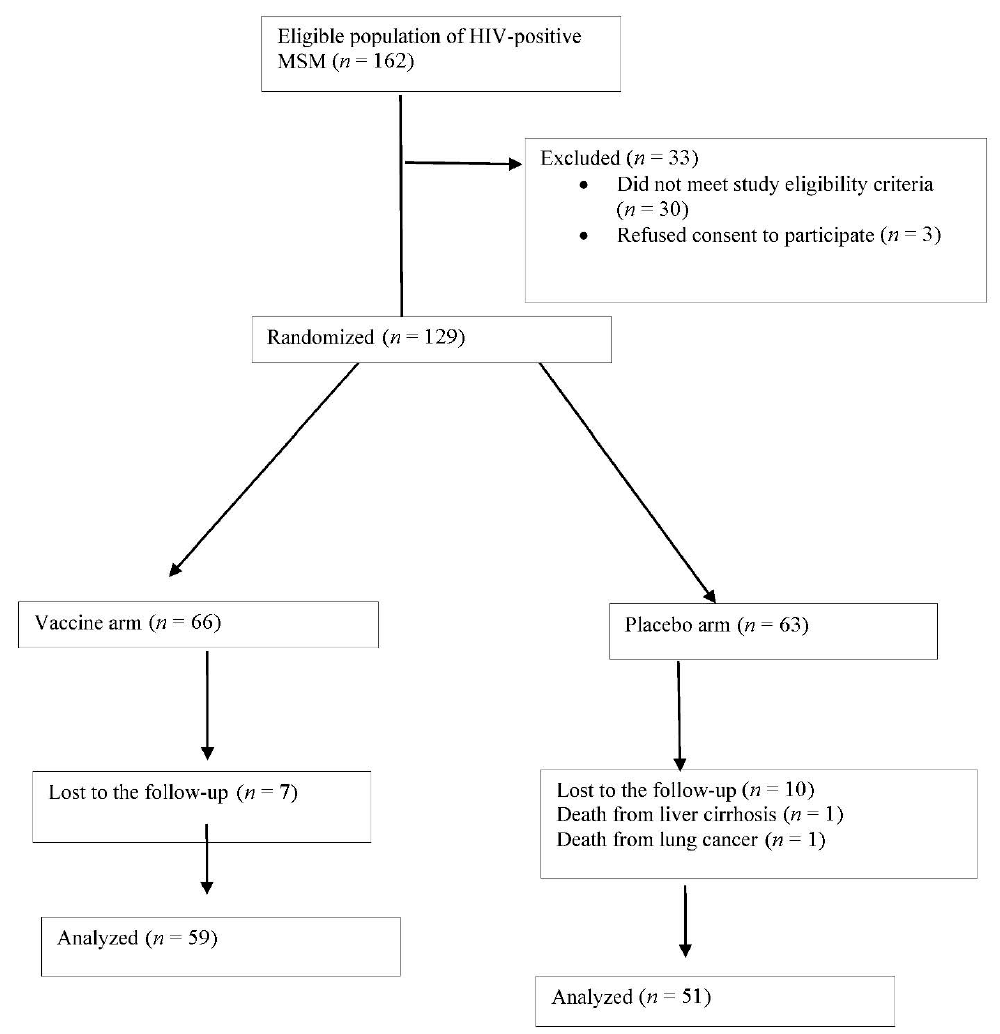
Figure 1. Flow of patients through the study.